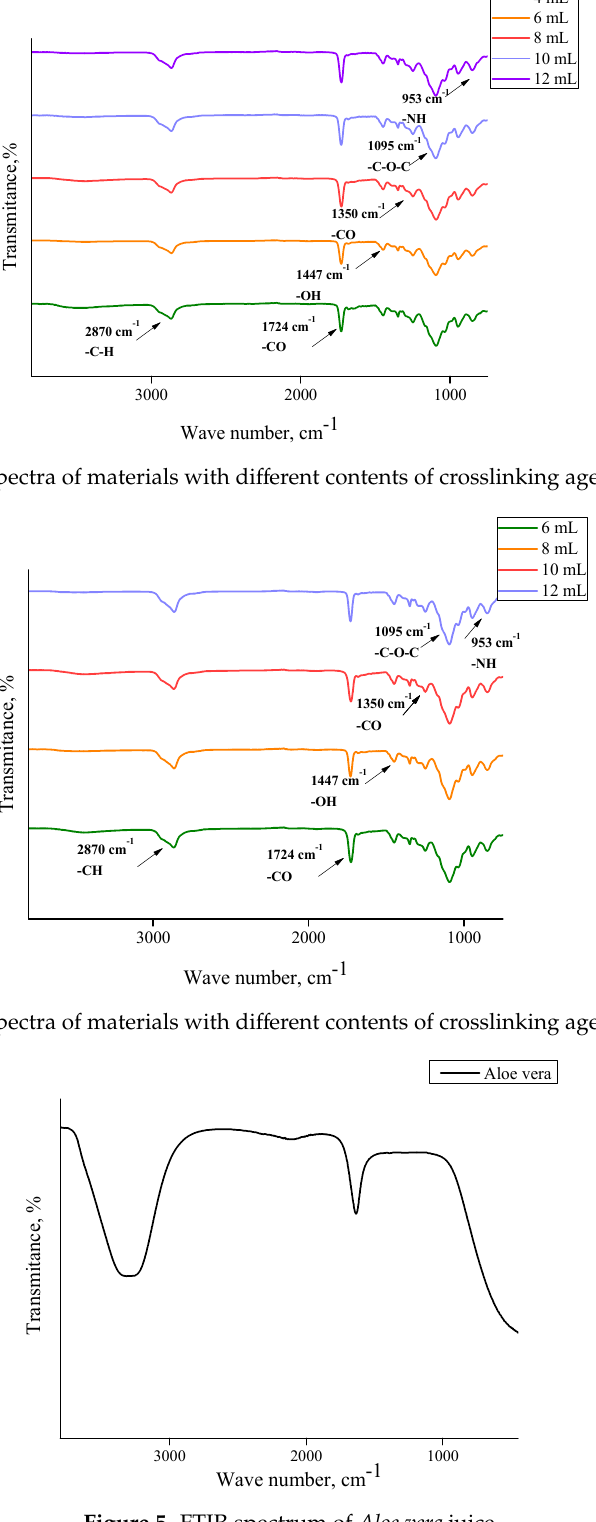
Figure 5. FTIR spectrum of Aloe vera juice.